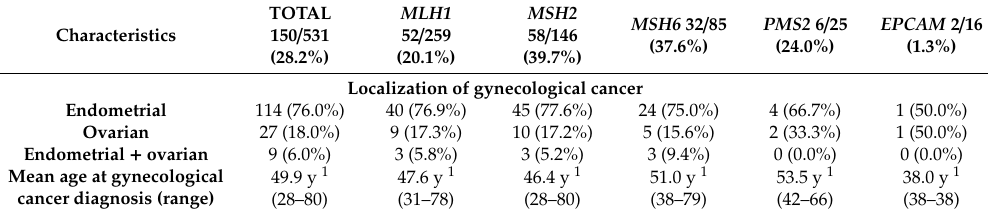
Table 4. Number and location of gynecological cancer according to mutated genes.